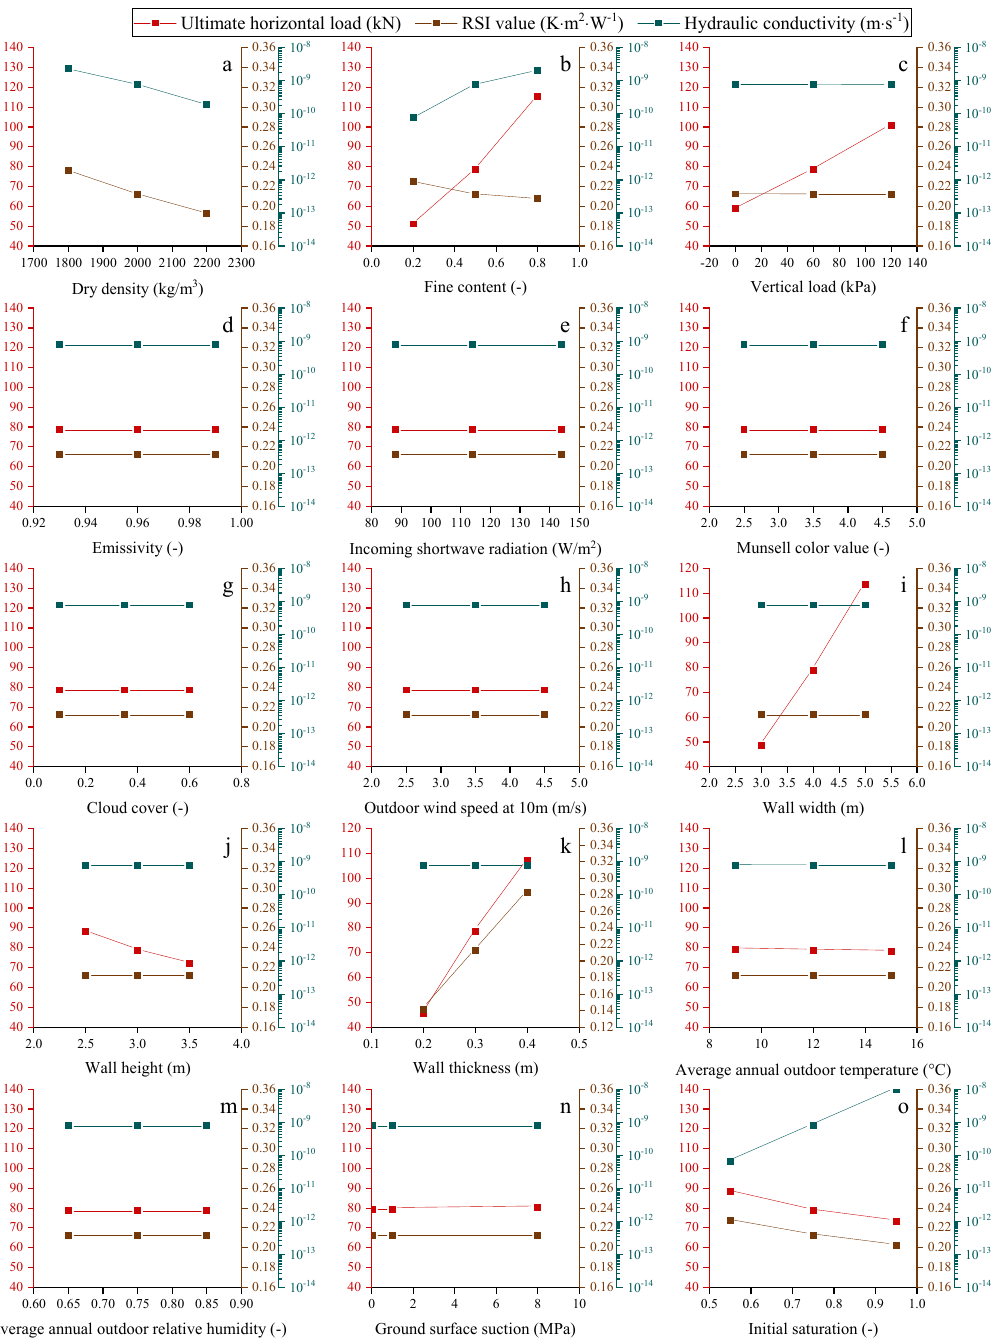
Figure 4. Variations of the average RSI value, hydraulic conductivity, and pushover strength with the influences of different factors for the newly built walls.